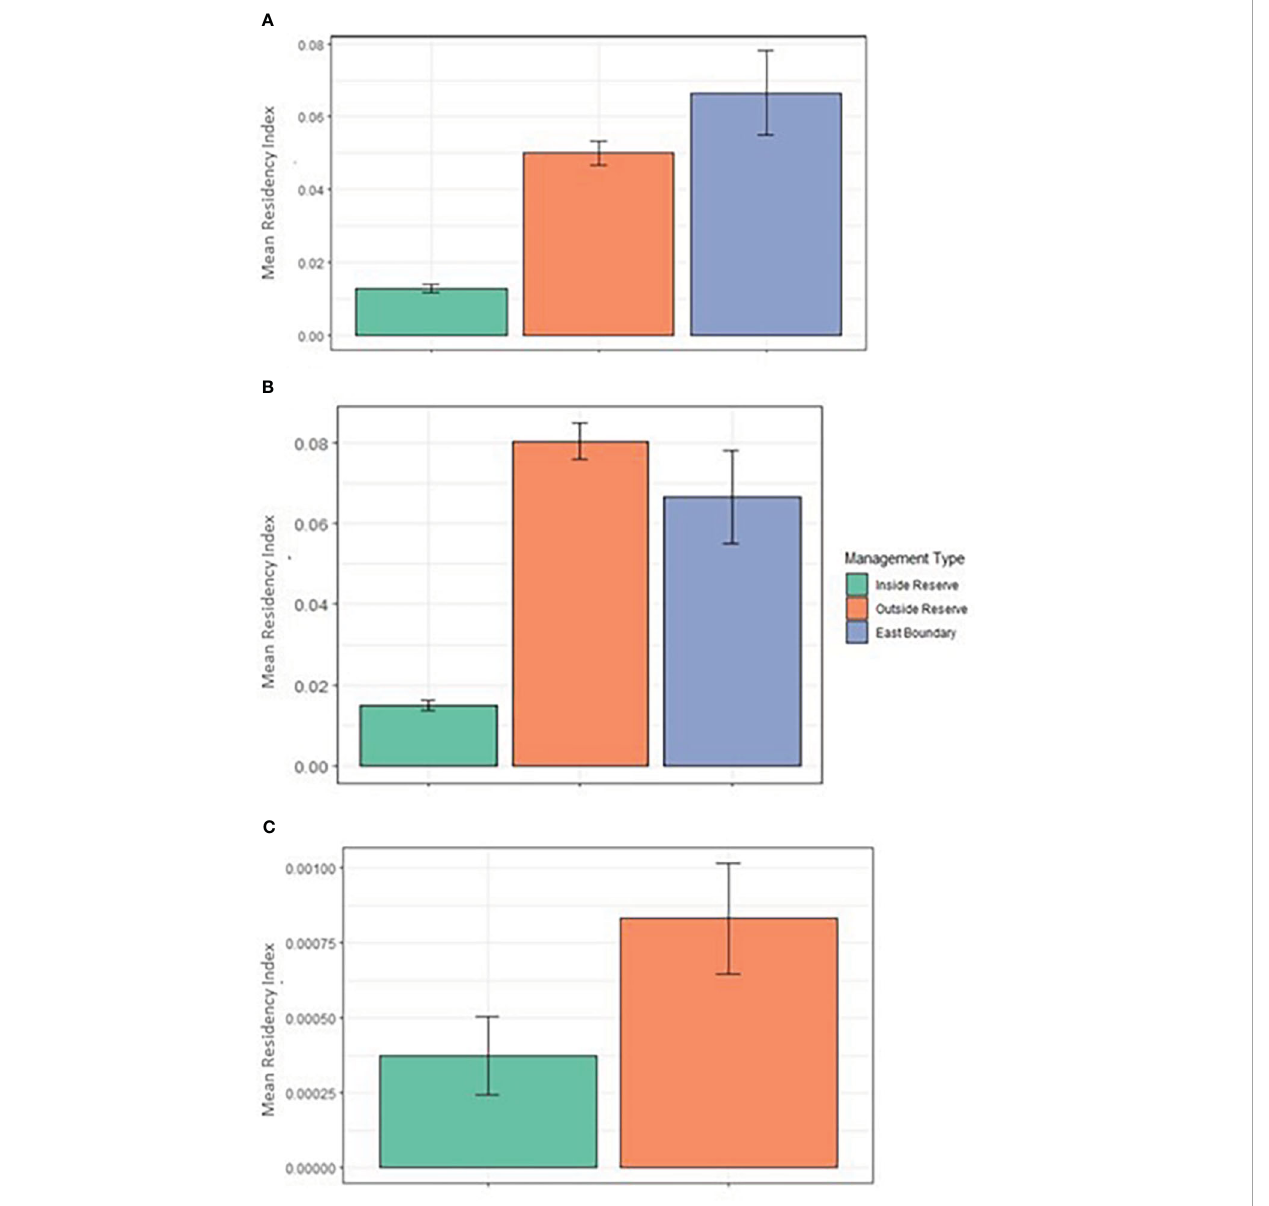
FIGURE 4 Mean residency index (± SE) by receiver management type for (A) local and regional receivers combined, (B) only local De Hoop MPA receivers, and (C) only regional receivers. In (A, C) , residency indces for management type “ Inside Reserve ” include receivers inside the De Hoop MPA and the Tstisikamma MPA (Eastern Cape), an MPA in the regional array where smooth hammerheads were also